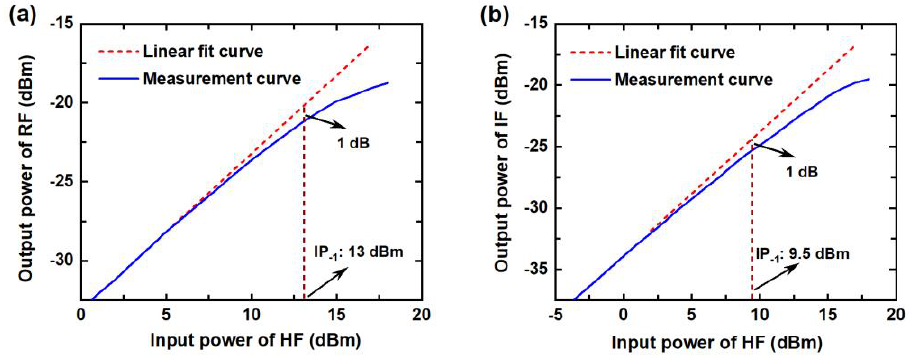
Figure 8. Input 1 dB power compression point (IP-1), ( a ) for upconversion and ( b ) for downconver- sion.